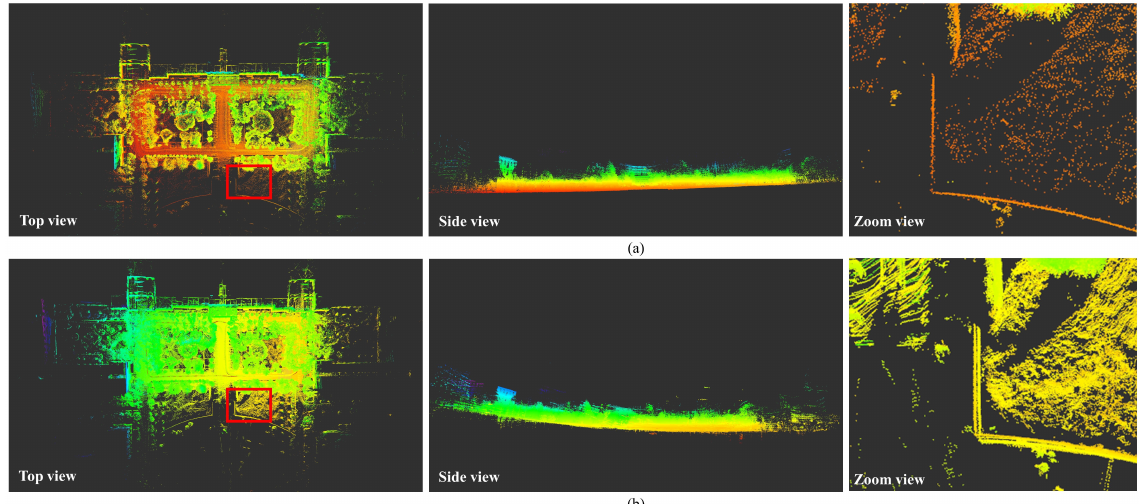
Figure 19. Top view, side view, and zoom view of the final 3D maps of campus obtained using our method vs LeGO-LOAM. ( a ) is our method and ( b ) is